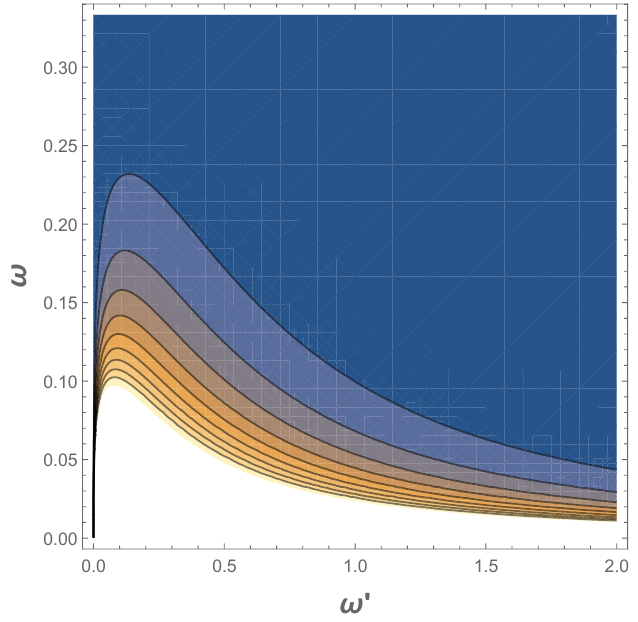
Figure 6. The Meijer-G spectrum, Equation (27), | β ωω (cid:48) | 2 as a contour plot, here M = 1. Integration over both ω and ω (cid:48) for the integrand ω | β ωω (cid:48) | 2 in Equation (32) gives a finite positive radiated energy consistent with the stress tensor result of Equation